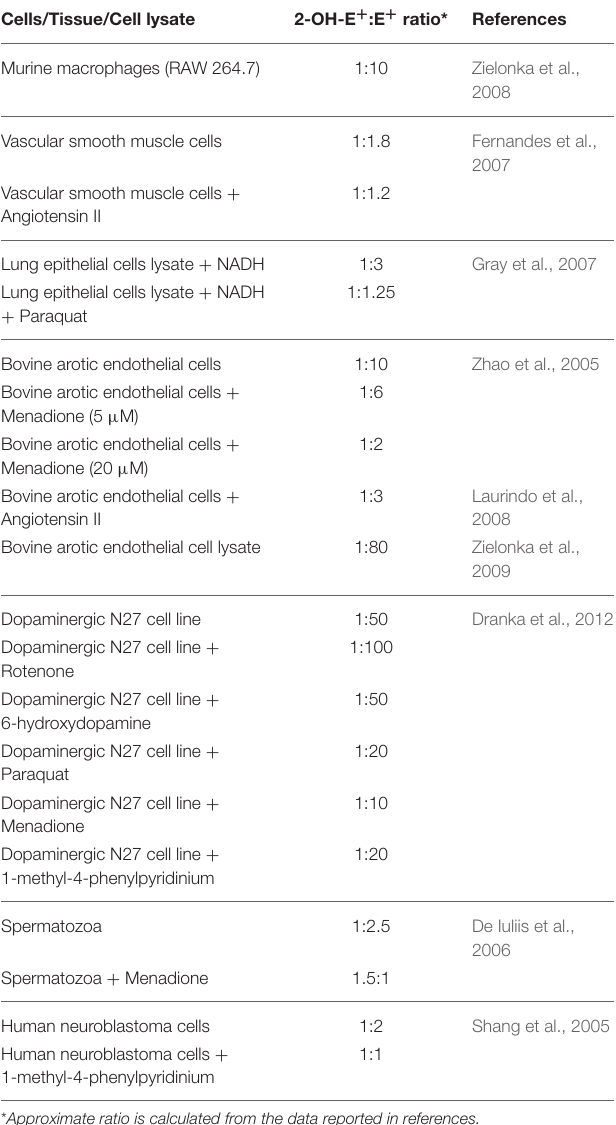
TABLE 1 | Relative detection of 2-OH-E + and E + in biological samples. Cells/Tissue/Cell